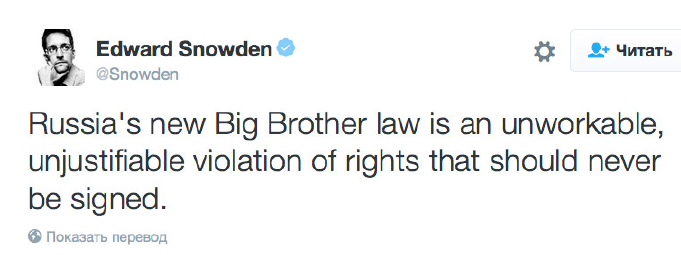
Figure 1. Edward Snowden’s critical tweet on the Yarovaya